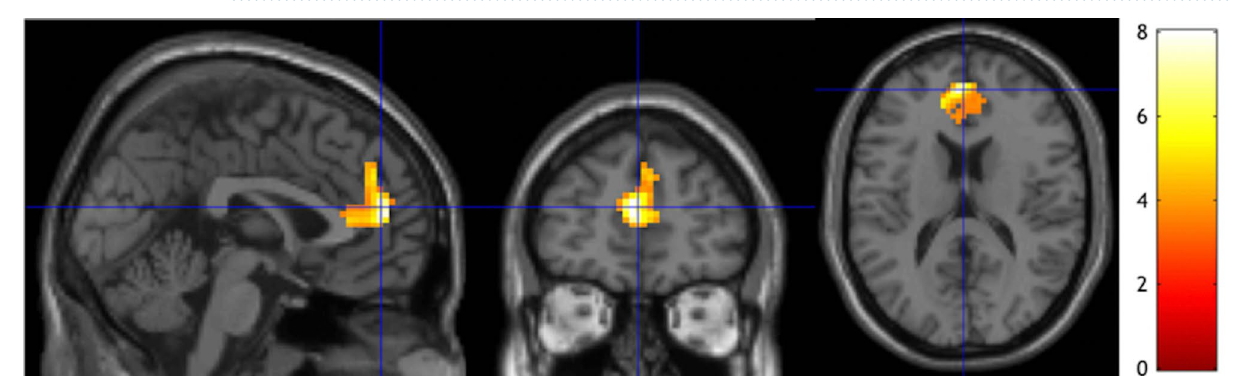
Figure 4. Regions of functional connectivity change associated with practice time. Regions overlaid on a standard brain template in which the meditation practice time was associated with functional connectivity with a seed ROI at the LSPL region and meditation practice time at the thresholds of a voxel-level p-value of 0.005 and corrected cluster-level p-value of 0.05. LSPL left superior parietal